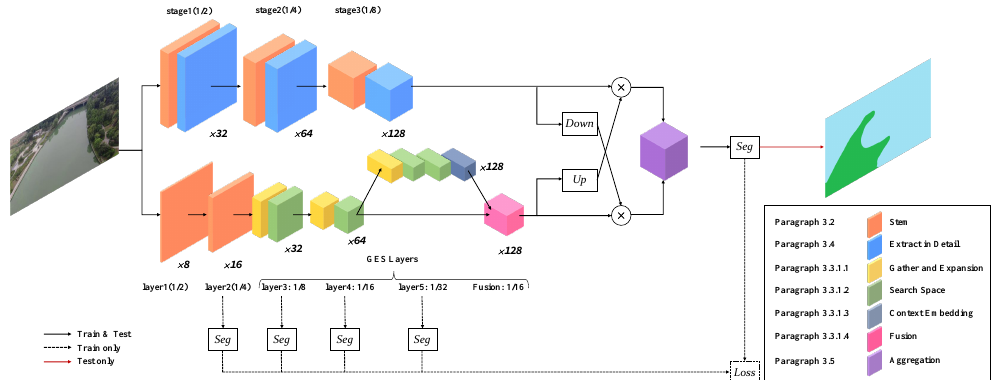
Figure 2. Overall architecture of